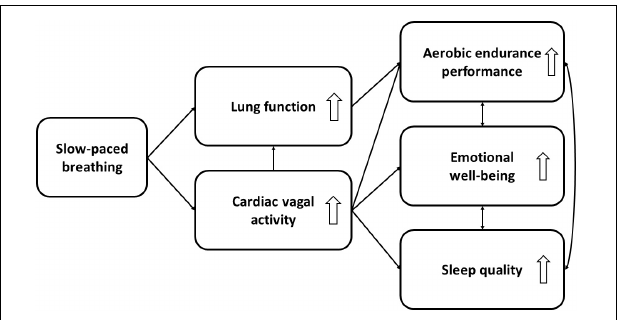
FIGURE 1 | Expected mechanisms of action between slow-paced breathing and aerobic endurance performance, emotional well-being, and sleep quality. White arrows depict the direction of the effect [i.e., either an increase (up) or decrease (down) of the psychophysiological